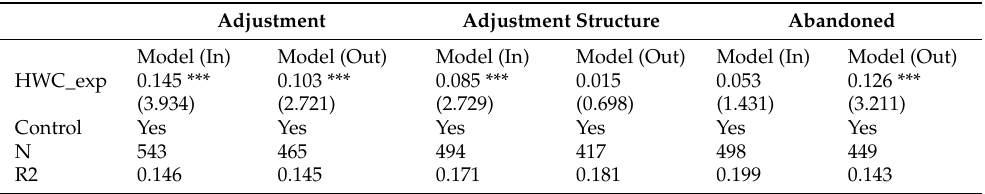
Table 4. Heterogeneity analysis of the influence of HWC on cultivated land use behaviour adjustment of farmers inside and outside of the Giant Panda National